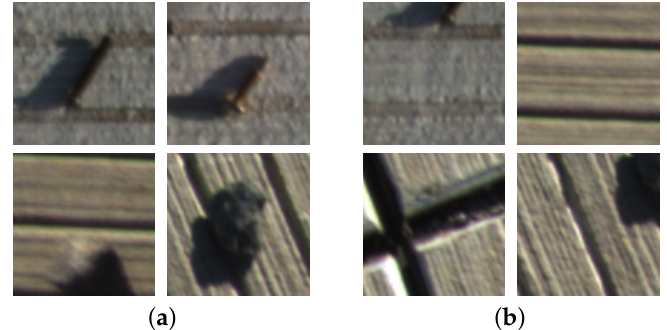
Figure 7. ( a ) Positive FOD samples with IoU ≥ 0.7; and ( b ) negative FOD samples with IoU ≤